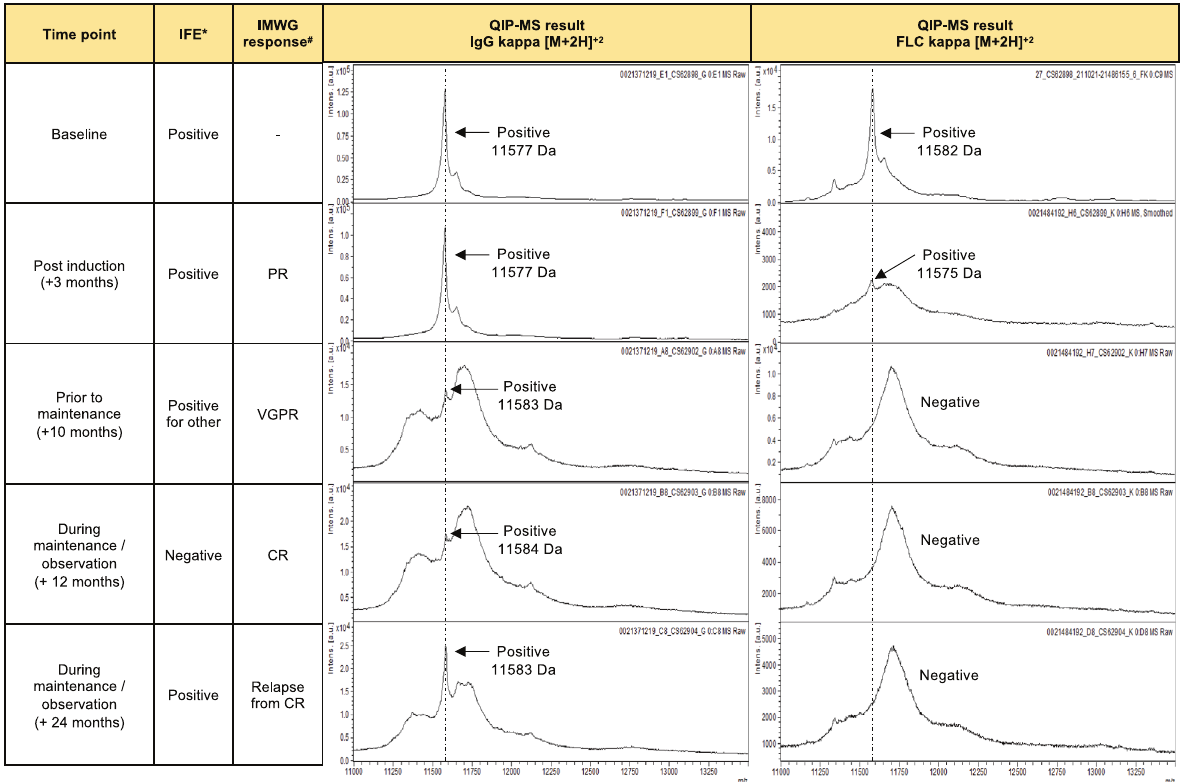
Fig. 1 Example on longitudinal response monitoring using QIP-MS and immuno fi xation. Exemplary case showing the immuno fi xation (IFE) results, IMWG response and QIP-MS spectra for the monoclonal intact immunoglobulin and free light chain at selected time points. In this patient, QIP-MS also identi fi ed a monoclonal IgG kappa ( m/z = 11577) + free kappa ( m/z = 11582) at baseline, indicating the presence of a patient-speci fi c clone co-expressing monoclonal intact immunoglobulin and free light chain. During maintenance/observation (after 24 months) the patient achieved a complete response (CR) while remaining QIP-MS positive. * serum IFE # according to IMWG criteria [15], IFE immuno fi xation, IMWG International Myeloma Working Group, PR partial response, VGPR very good partial response, CR complete